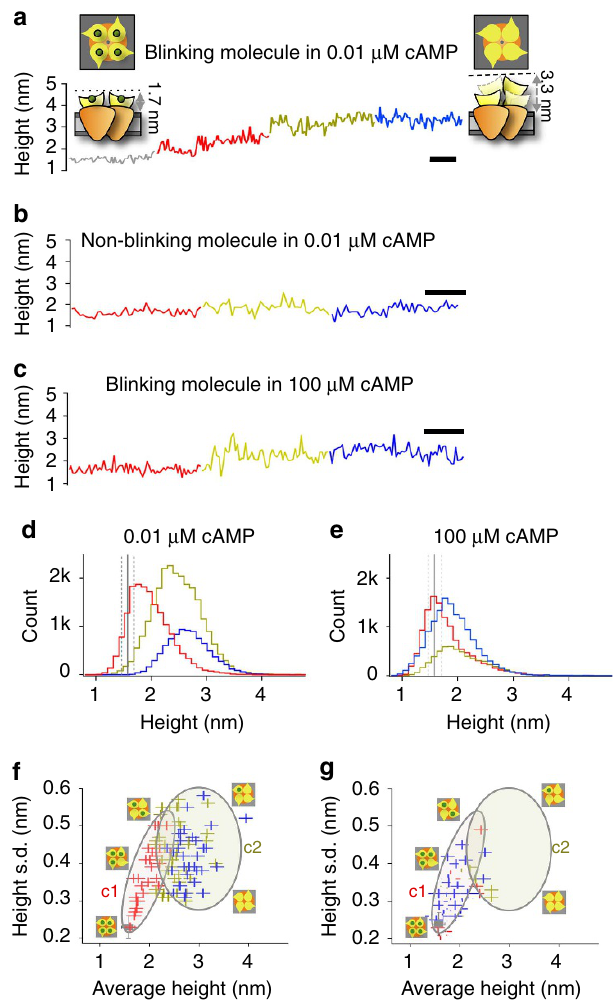
Figure 5 | MloK1 blinking heights increase over time in low cAMP. ( a ) Height versus time representative trace of an individual channel after incubation for 30 (red), 60 (yellow) and 90 (blue) minutes in 10nM cAMP. A non-blinking channel from the same patch is shown in grey. Over time the molecule traverses several height levels. Cartoons representing liganded and unliganded MloK1 are shown. ( b ) Height versus time representative trace of a non-blinking channel after 30, 60 and 90min in 10nM cAMP (same colour scheme as in a ). In contrast to the blinking molecule, no progressive height increase could be detected. ( c ) Height versus time representative trace of a blinking channel at 100 m M cAMP after 30, 60 and 90min (same colour scheme as in a ). The molecule starts blinking at the second scanning round (60min) and keeps blinking at the same height level throughout the entire experiment. Scale bar: 10s ( a – c ). ( d , e ) Histograms of MloK1 heights after 30, 60 and 90min incubation in 10nM cAMP ( d ) or100 m M cAMP ( e ), respectively. Colour code is as in a . As a reference, the average height (solid line) and s.d. (dashed line) of non-blinking down-state molecules (grey, n ¼ 18 (10nM cAMP) and n ¼ 15 (100 m M cAMP) molecules) are shown. ( f ) Correlation between average height and height s.d. for each molecule at 10nM cAMP. Colour code as above. Each cross in the distribution is the average height of a single molecule plotted against the s.d. from all 500 frames. Mean ± s.d. of non-blinking molecules ( n ¼ 18) are shown as a grey square. Blinking molecules pass through different height regimes (clusters c1 and c2, outlined by large circles). ( g ) correlation between average height and height s.d., at 100 m M cAMP. Mean ± s.d. of non-blinking molecules ( n ¼ 15) is shown as a grey